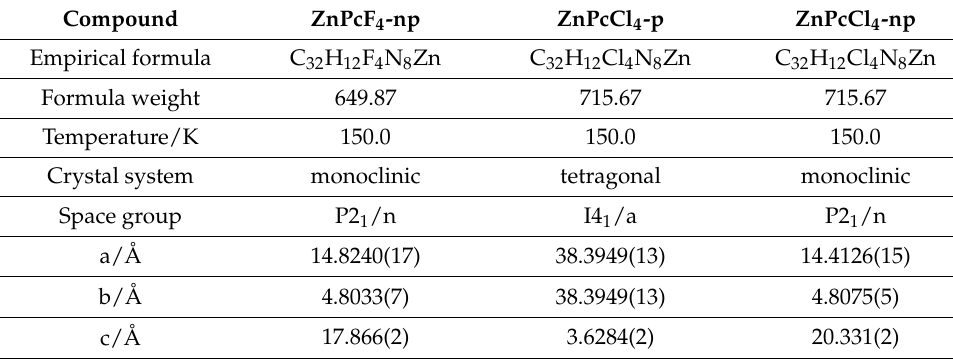
Table 1. Unit cell parameters and refinement details.